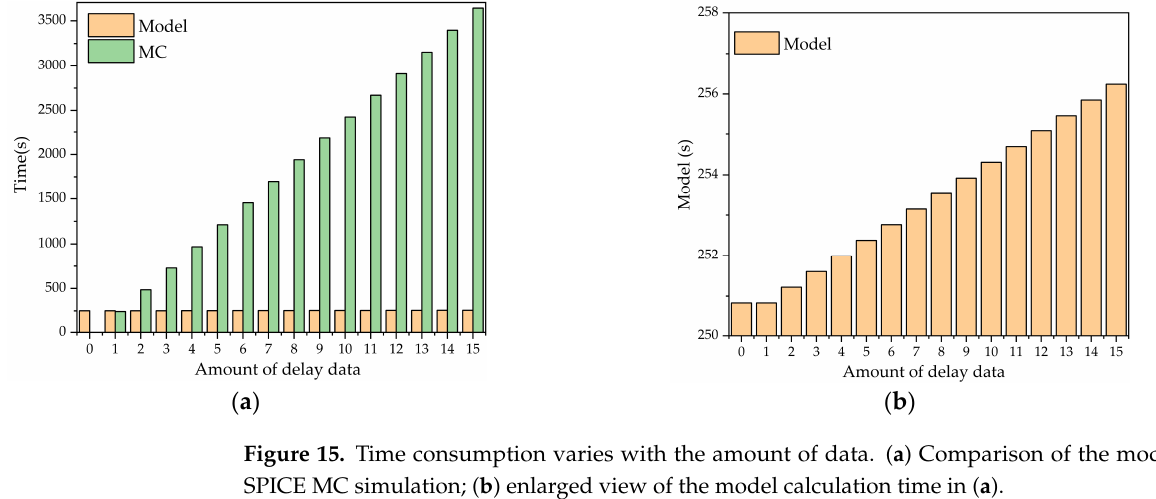
Figure 14. CDF curves comparison among MC simulation, IGD fitting and IGD delay modeling prediction ( a ) Vgs = 0.25 V; ( b ) Vgs = 0.27 V; ( c ) Vgs = 0.30 V.